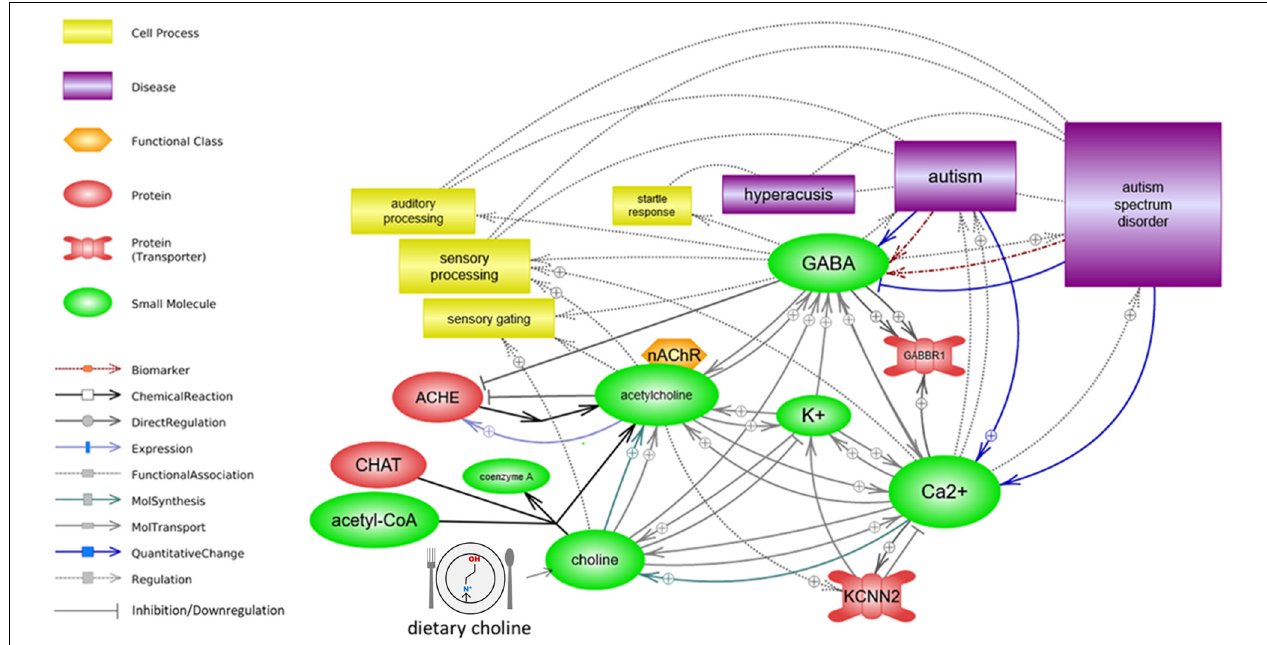
FIGURE 2 | Sensory processing is associated with autism functionally, in the context of ion transport and cholinergic signaling. Acetylcholine regulates both the ion transport and the GABA signaling. A deficiency in its precursor, dietary choline, may impact ion transport, GABA ⇒ GABBR1 signaling, and KCNN2 /SK2 channel function, either or all of which may result in altered sensory processing